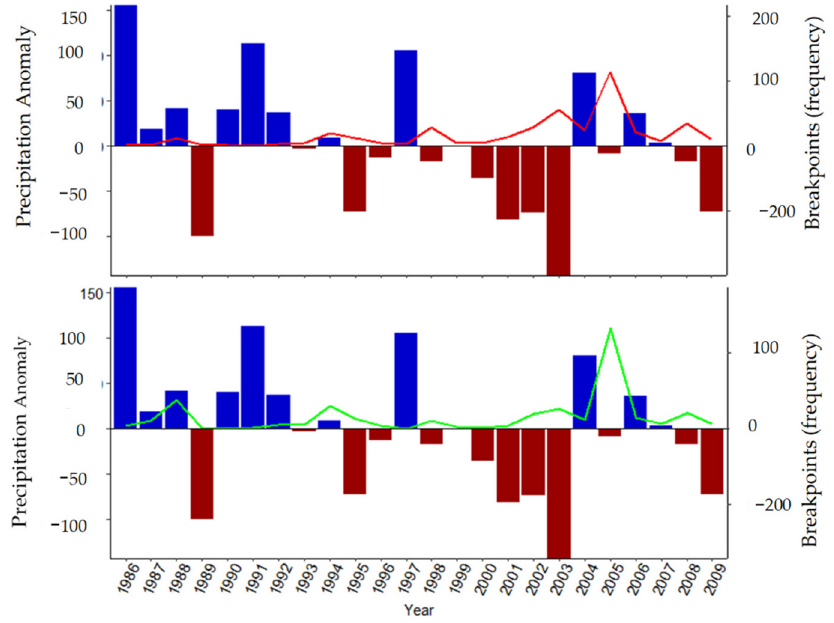
Figure 3. A summary of the number of detected significant breakpoints along with corresponding precipitation anomaly (mm) based on a 33 year mean from PRISM. Top and bottom panels show pixels with decreasing (red line) and increasing (green line) trends in productivity, respectively. From all significant breakpoints, 58%, 20%, and 15.7% were observed in shrubland, grassland, and evergreen forest ecosystems, respectively (Figure 5). The highest number of detected breakpoints was 250 (or 31% out of 814) in 2005. Among them, shrublands and grasslands combined accounted for 87.6% (219), out of which 72.8% and 14.8% were over shrublands and grasslands, respectively. Table 2. A summary of the identified direction of change in productivity based on the TSS-RESTREND method in New Mexico during the 1982–2015 period.